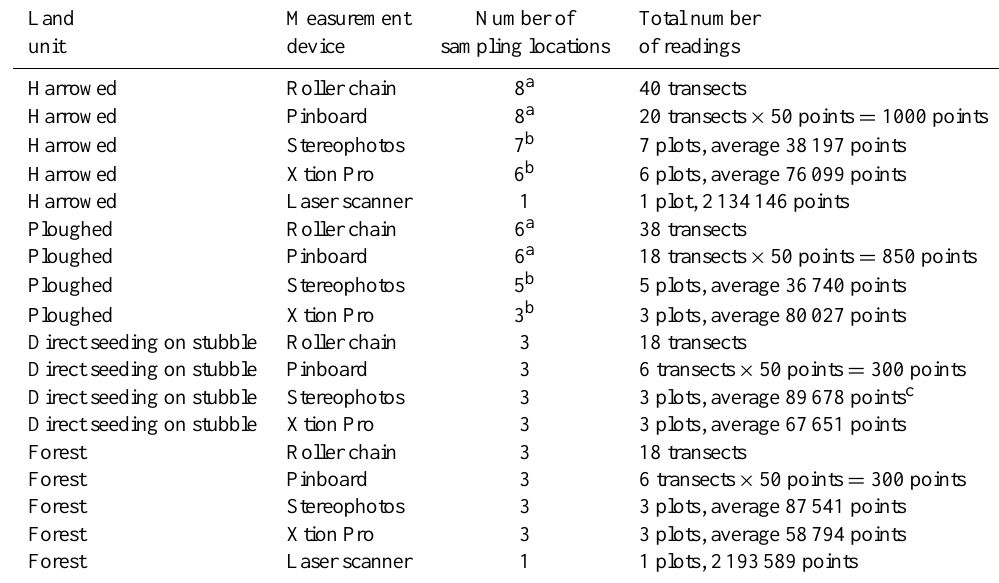
Table 1. Land unit, number of plots, sample locations and point height measurements per method.